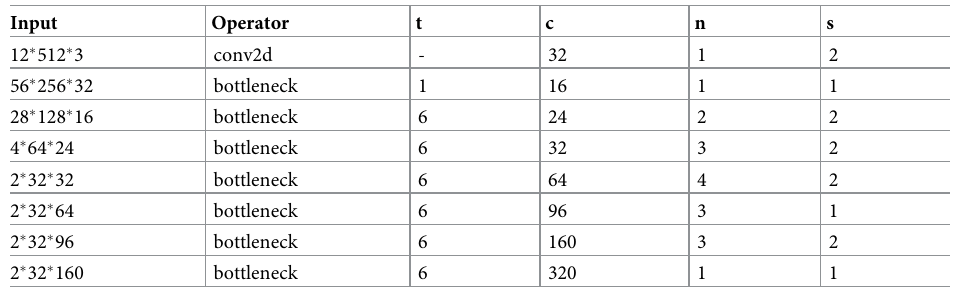
Table 2. Structure diagram of MobileNetV2